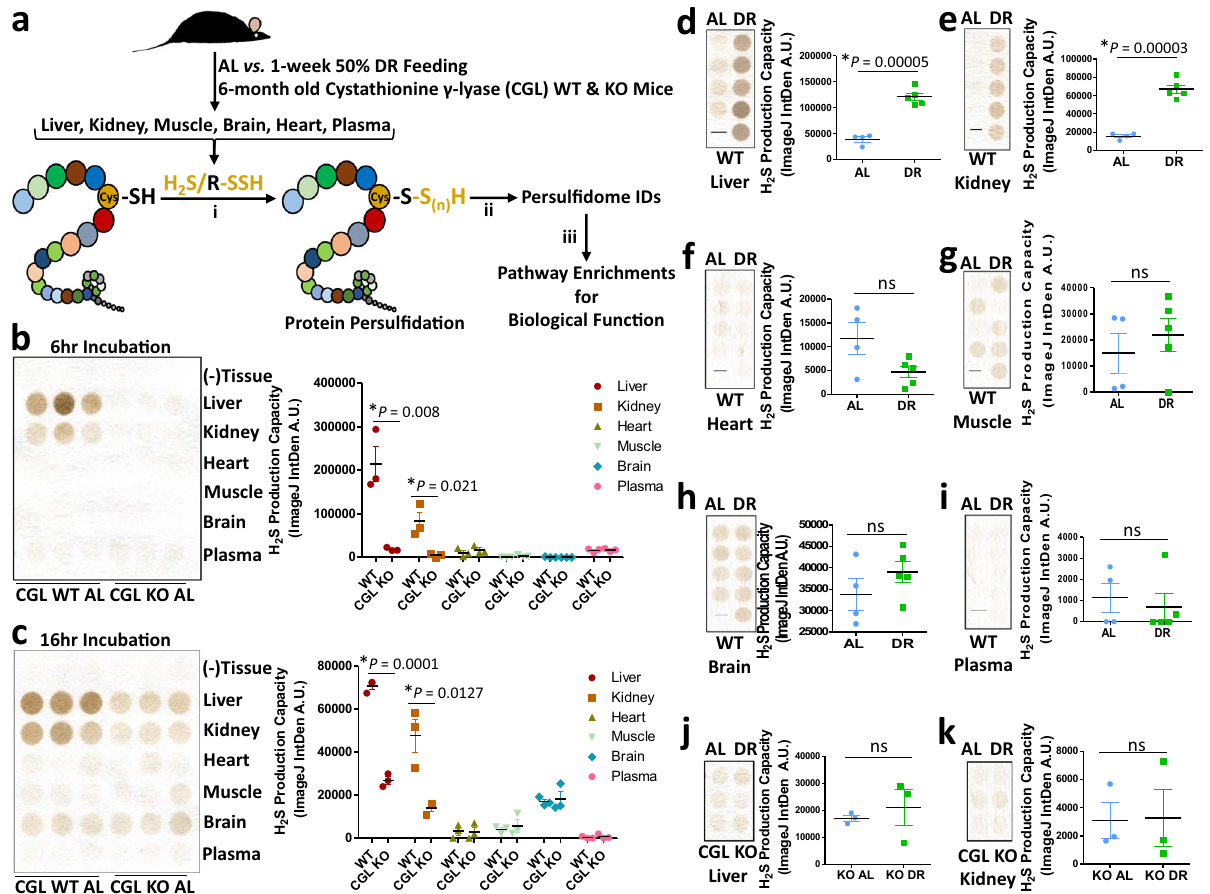
Fig. 1 Diet and cystathionine γ -lyase (CGL) status impact H 2 S production in a tissue speci fi c manner. a Graphical presentation of the overarching experimental setup. Six-month-old male CGL wildtype (WT) and total body knock out (KO) mice were placed on ad libitum (AL) or 50% dietary restriction (DR) diets for 1 week prior to tissue harvest. Tissues were analyzed for ( i ) H 2 S production capacity via the lead acetate/lead sul fi de method, ( ii ) protein persul fi dation pro fi les via the biotin thiol (BTA) assay, and ( iii ) biological pathway enrichment/function of the identi fi ed persul fi dated proteins. b , c H 2 S production capacity in tissues in AL fed CGL WT ( n = 3 mice/group) and CGL KO ( n = 3 mice/group) mice at short 6 h ( b ) and long 16 h ( c ) exposures of the same assay plate. Means are shown and error bars are ± SEM. The asterisk indicates the signi fi cance of the difference in the average tissue-speci fi c H 2 S production capacity between CGL WT and KO mice after subtracting the ( – ) Tissue negative controls as background; with P values obtained from two-sided Student ’ s t test. d – i H 2 S production capacity in tissues harvested from CGL WT mice after 1 week of AL ( n = 4 mice/group) or 50% DR ( n = 5 mice/group) feeding. j , k H 2 S production capacity in liver ( j ) and kidney ( k ) in CGL KO mice after 1 week of AL ( n = 3 mice/group) or 50% DR ( n = 3 mice/group) feeding. Means are shown and error bars are ± SEM. The asterisks indicate the signi fi cance of the difference between the dietary treatment groups; with P values obtained from two-sided Student ’ s t test. ns not signi fi cant. Negative values after subtracting background have been converted to zero. The dash mark in the lead acetate/lead sul fi de images in ( d – i ) indicates no sample loaded in that location. Source data are provided as a Source Data fi le. See also Supplementary Fig.